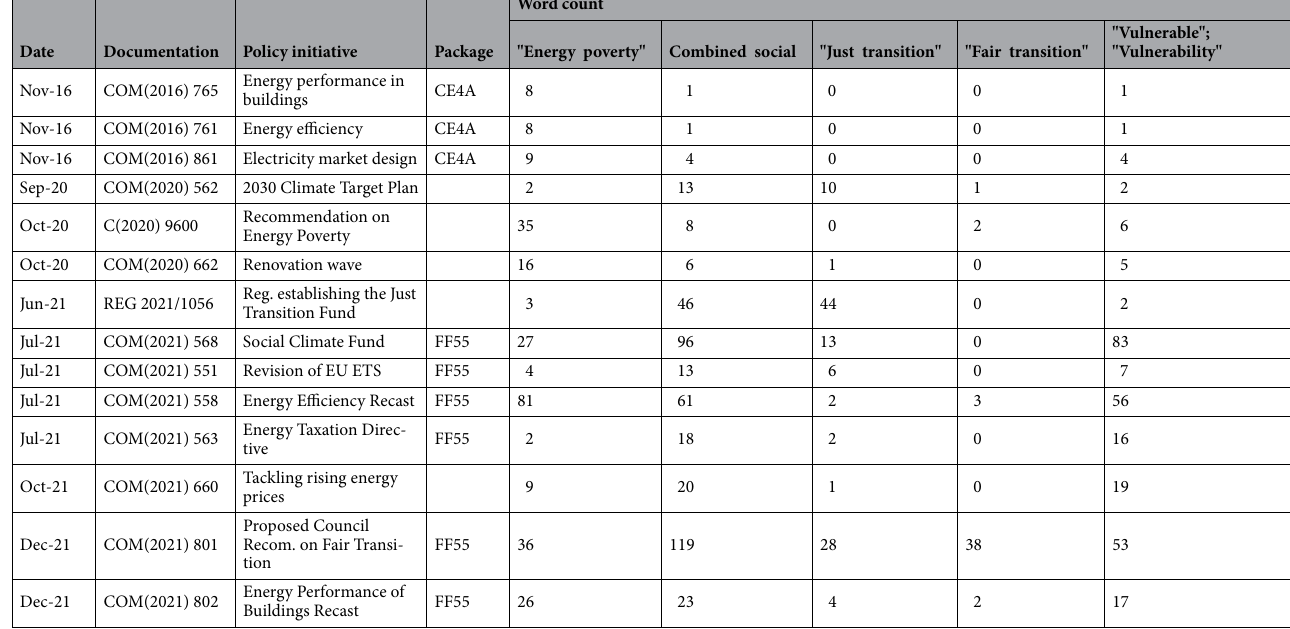
Table 1. Overview of selected policy initiatives. CE4A Clean Energy for All Europeans package, FF55 Fit for 55